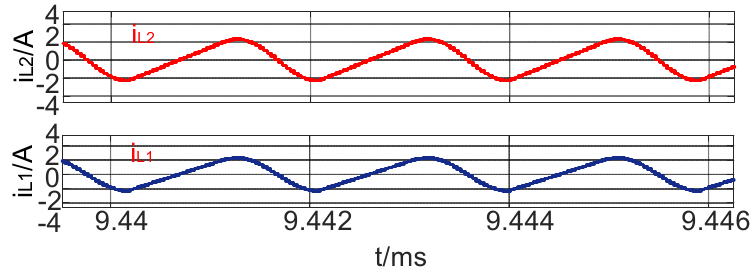
Figure 9. Inductive current waveform for the two topologies.